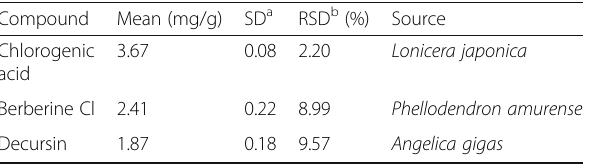
Table 2 Concentrations of the three marker components in the ChondroT by HPLC ( n = 3)